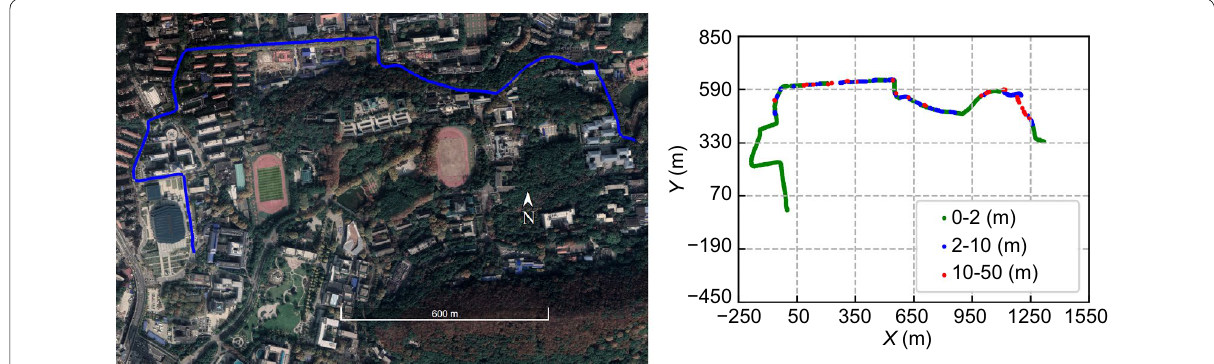
Fig. 11 Field test trajectory. Left: top view of the trajectory on google earth, right: positioning result of PPP when using multi-GNSS data in GNSS difficult